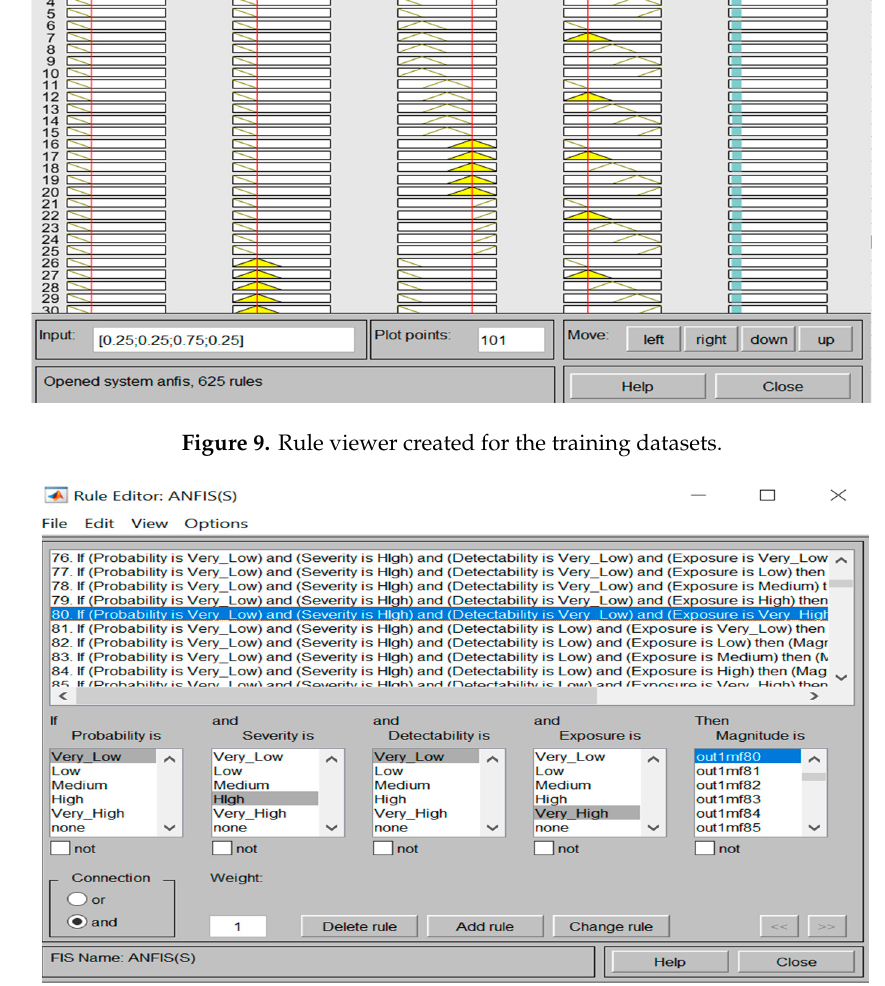
Figure 10. The constructed rules by ANFIS Sugeno.